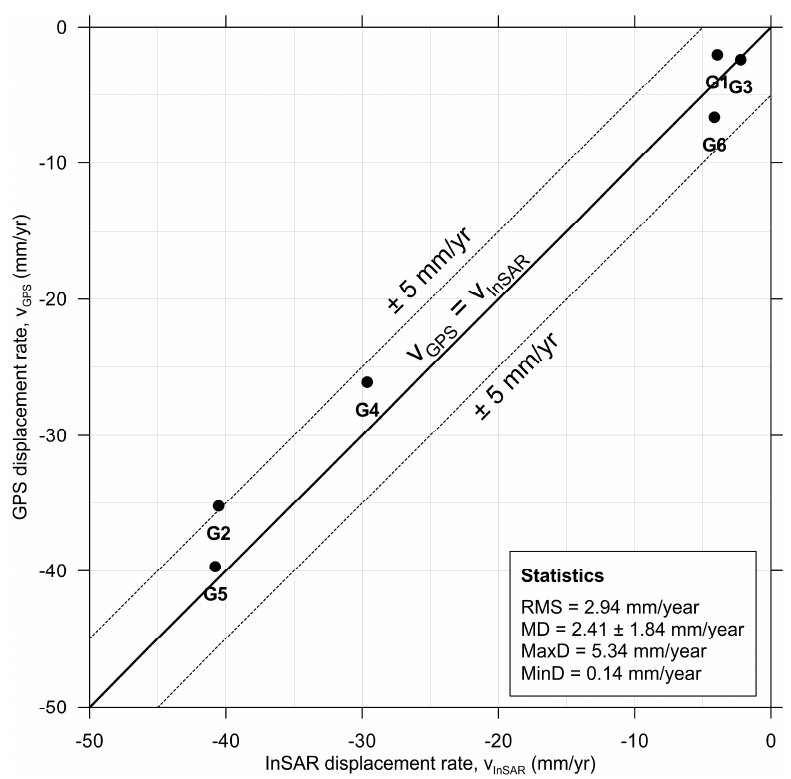
Figure 5. Comparison of GPS and Envisat InSAR results for points G1–G6. See GPS stations location in Figure 3.